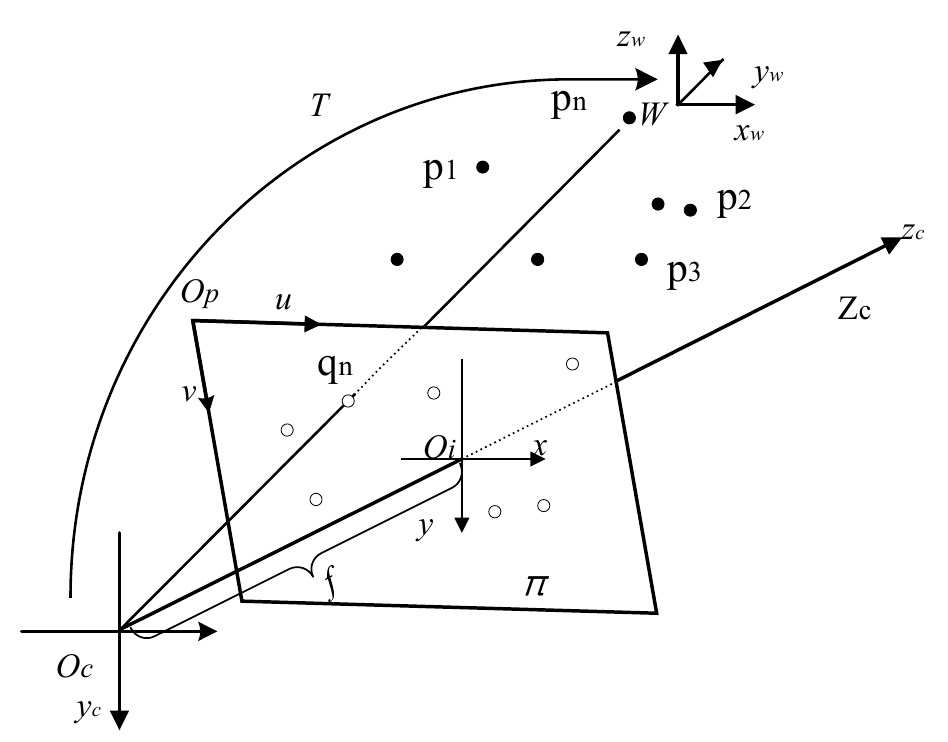
Figure 3. PNP problem diagram. Set the homogeneous coordinates of the target localization points in the world coordi- nate system as: